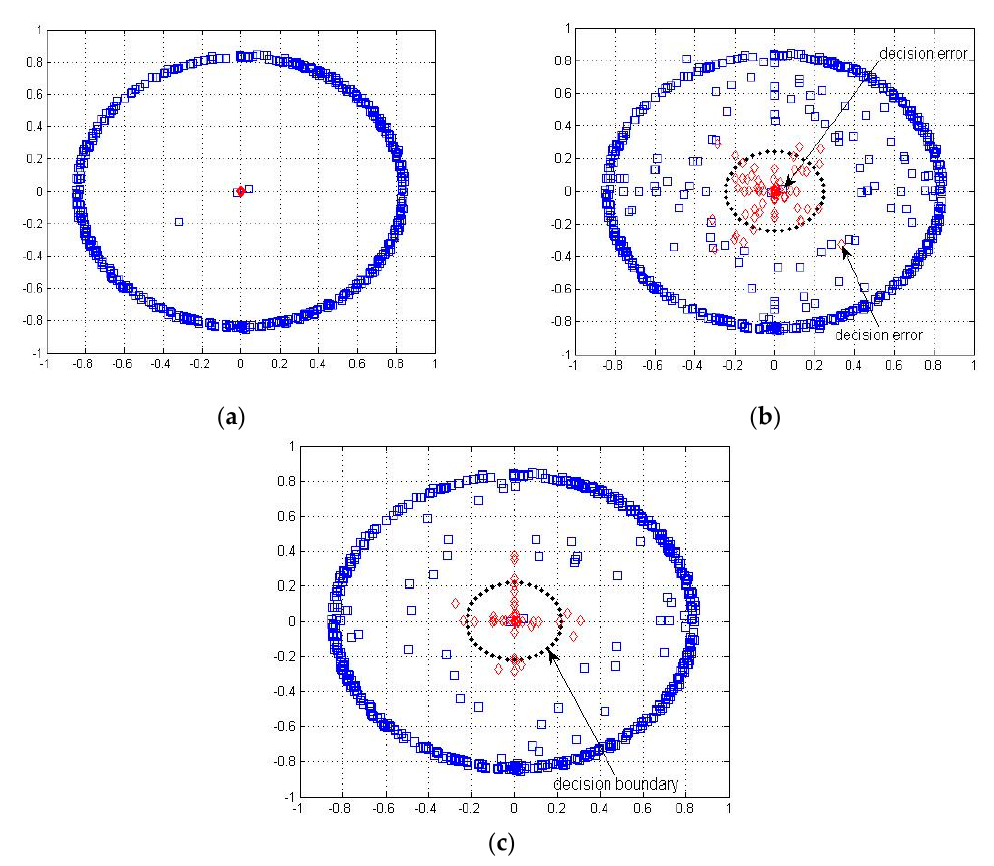
Figure 3. The symbol constellation diagram. ( a ) Original symbol constellation. ( b ) Recovery symbol constellation (signal/noise ratio (SNR) = 16 dB). ( c ) Recovery symbol constellation (SNR = 28 dB).